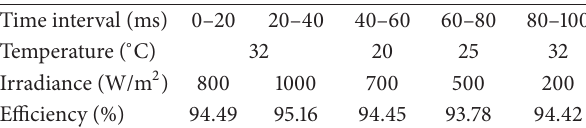
Table 5: Efficiency obtained for the CV technique under distinct operating conditions.